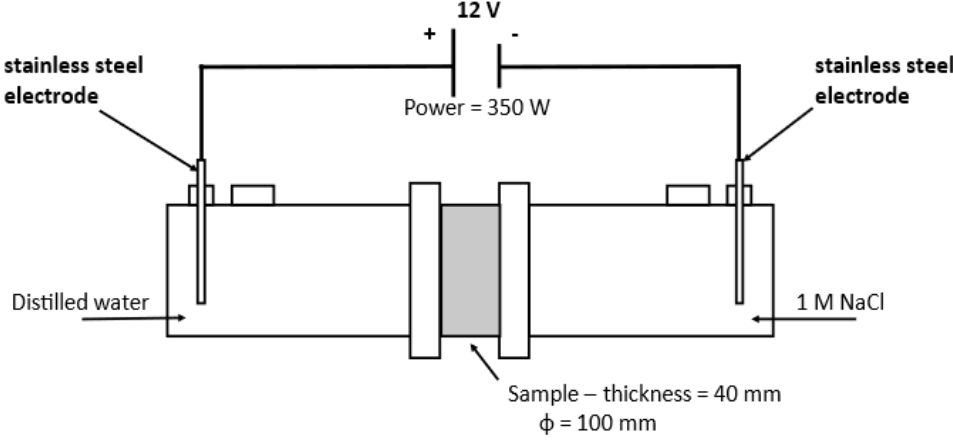
Figure 3. Schematic drawing of the chloride migration test